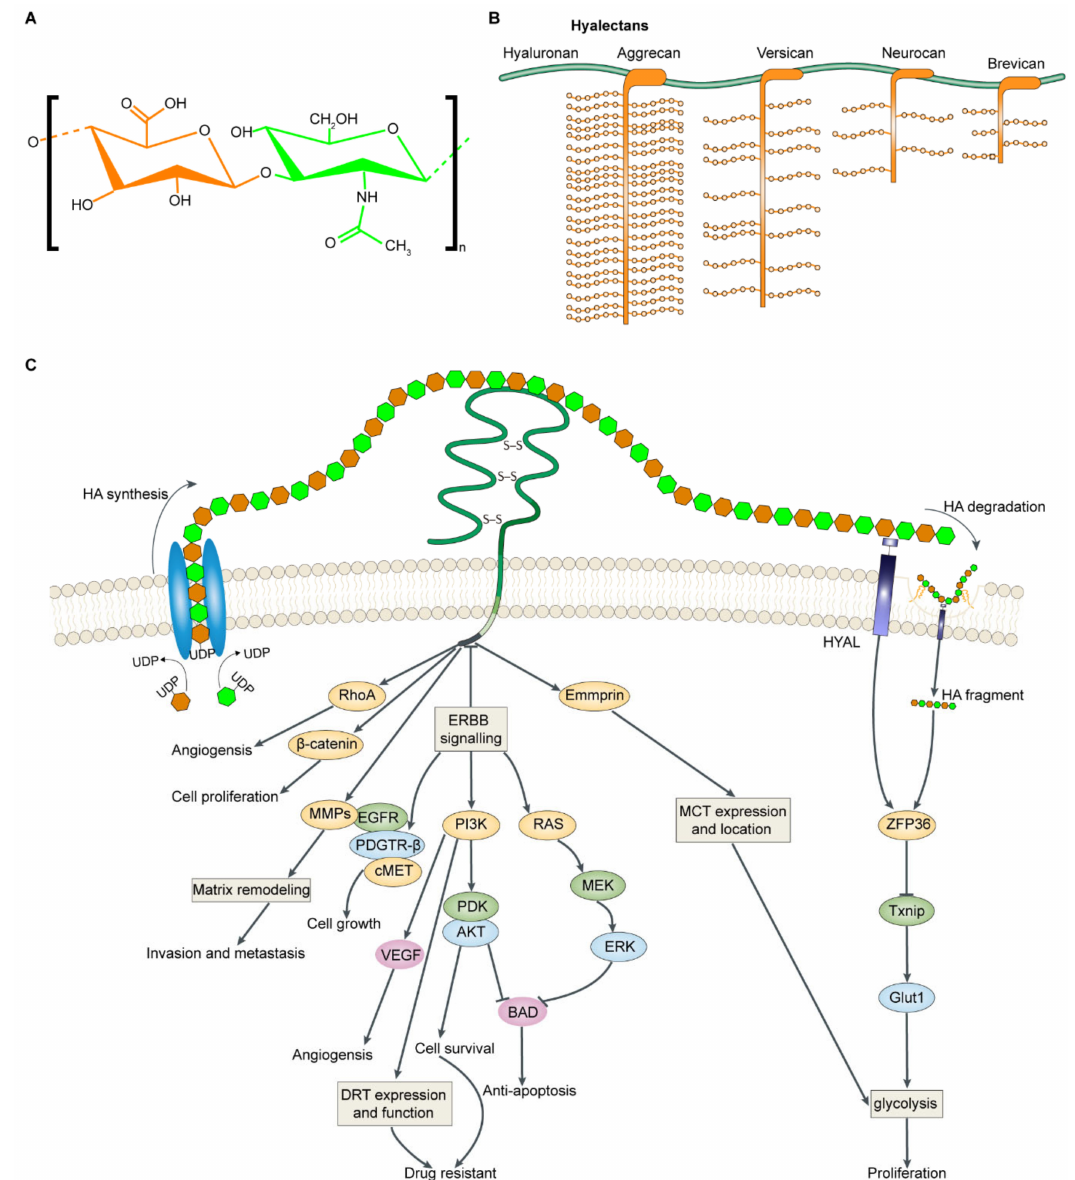
Figure 1. HA in tumor development. ( A ) Structure of HA. ( B ) The interactions between HA and hyalectans (aggrecan, versican, neurocan, and brevican) in the ECM. ( C ) The synthesis, degradation process, and roles in cancer progression of HA. HA is synthesized by HAS1, HAS2 and HAS3 in cell membrane. CD44 binds to HA to transduce signaling and its downstream e ff ectors. HA-CD44 binds RhoGTPases and β -catenin to induce angiogenesis and proliferation. HA-CD44 stimulates MMP production and MMP presentation on cell surfaces and thus leads to cell invasiveness and metastasis. HA-CD44 induces ERBB2 activity to active PI3K / AKT, RAS / ERK, and EGFR signals. PI3K can activate EGFR / PDGTR / cMET to promote cell growth. PI3K signaling regulates DRT expression and function also phosphorylates AKT to activate cell-survival signaling thus inducing drug resistance. PI3K / AKT and RAS / ERK signal phosphorylate, the pro-apoptotic factor BAD, to inactivate it. HA-CD44 interacts with emmprin which locate MCTs on the cell membrane to increase the release of lactate and glycolysis. HA is degraded by HYAL into smaller molecules. HA fragment signals through RTKs to activate ZFP36, causing TXNIP degradation, hindering TXNIP-mediated GLUT1-internalization, leading to more glucose transport and prompting glycolysis to motivate cancer cell proliferation. HAS: hyaluronan synthase; HA: hyaluronan; MMP: metalloproteinase; DRT: drug-resistance transporter; HYAL: hyaluronidase; RTKs: receptor tyrosine